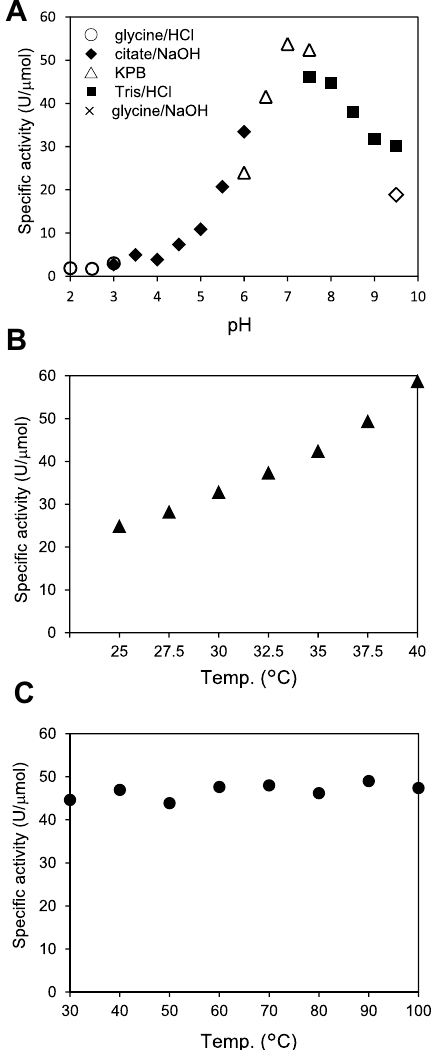
Figure 6. Effect of pH and temperature on granaticin activity. The catalytic activity of granaticin was measured at various pH values at 30 °C ( A ) and at various temperatures at pH 7.0 ( B ). The activity at temperatures higher than 40 °C could not be measured because of the operation limits of the oxygen electrode. The thermostability of the compound ( C ) was also studied by incubating granaticin solution at various temperatures for 1 h prior to the activity measurement. A representative result of repeated experiments is